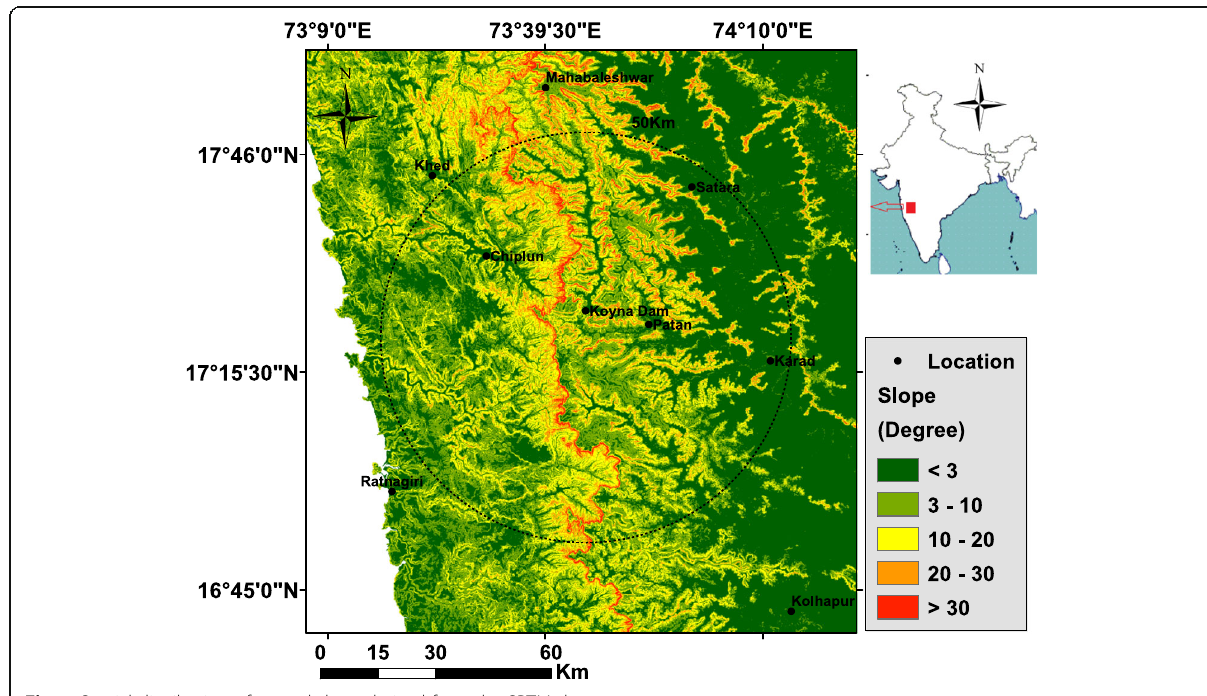
Fig. 4 Spatial distribution of natural slope derived from the SRTM data